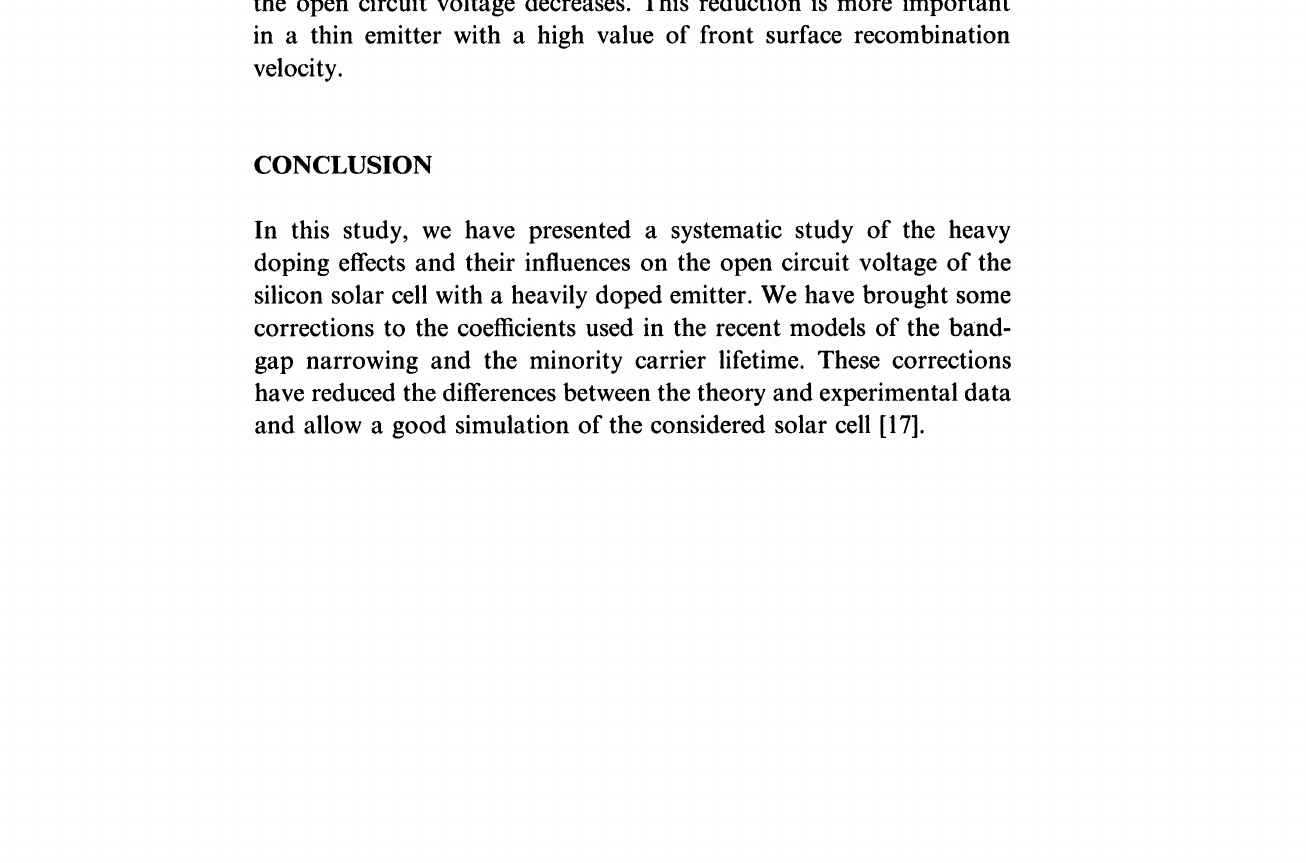
FIGURE 8 Variation of the open circuit voltage Voc according to the acceptor concentration NA. For curves (A), (B) and (C), we have: Curve (A): N,-- 1016cm -3, X= 0.21am, H=295tm, Sb 1015cms -I, Sf= 106cms-l; Curve (B): NA--1016cm -3, X= 0.6tm, H= 295tm, Sb= 1015cms -l, Sf= 102cms-l; Curve 155 15 (C):NA =10 cm- X--0.51am, H=2951am, Sb=lO cms- Sf--IO